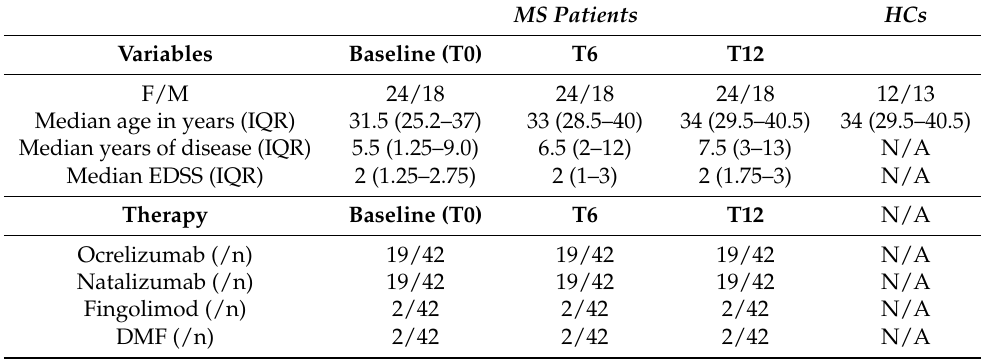
Table 3. Demographics and disease characteristics of MS patients and